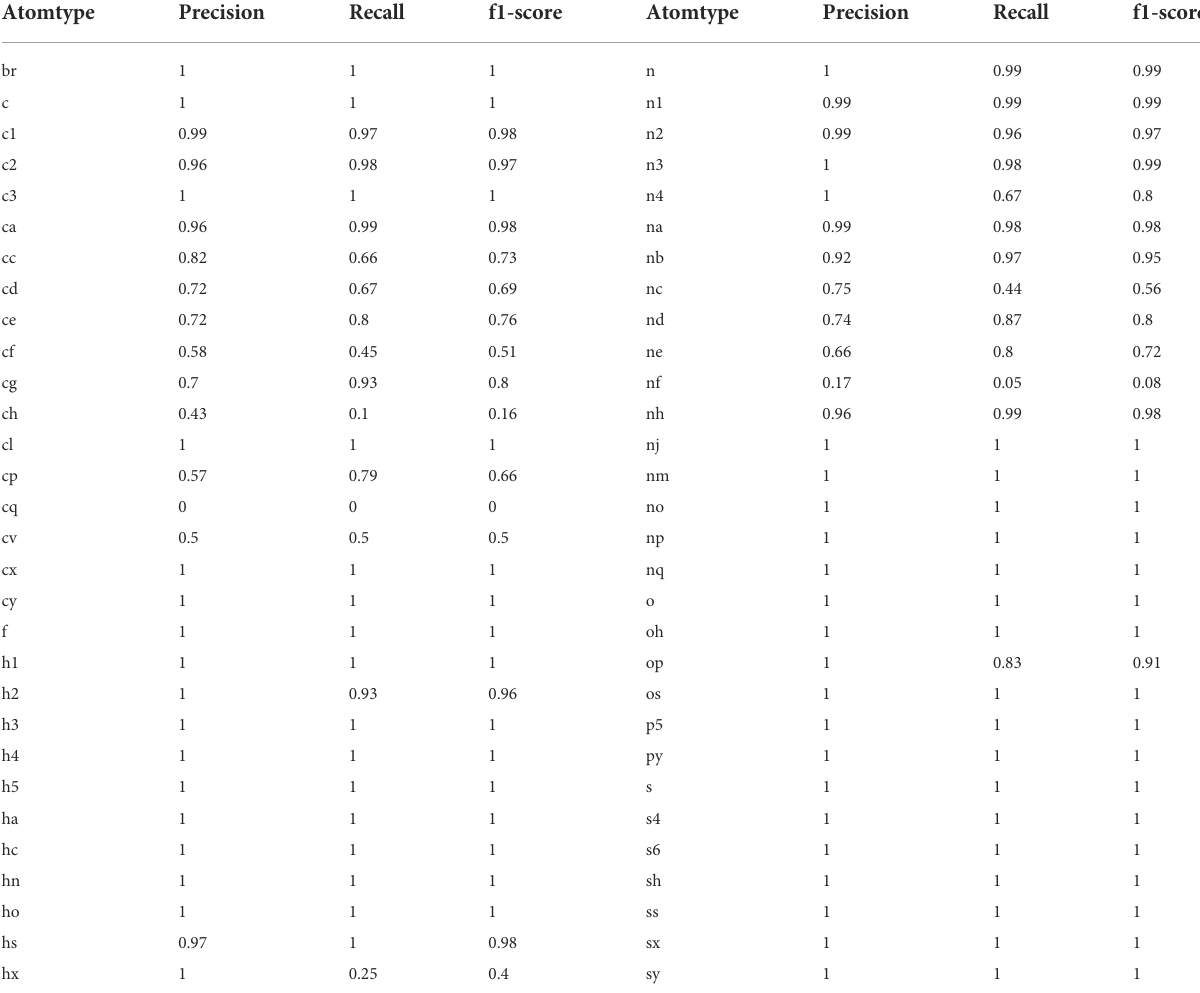
TABLE 2 Accuracy of the prediction of atom types using a neural network model. Atomtype